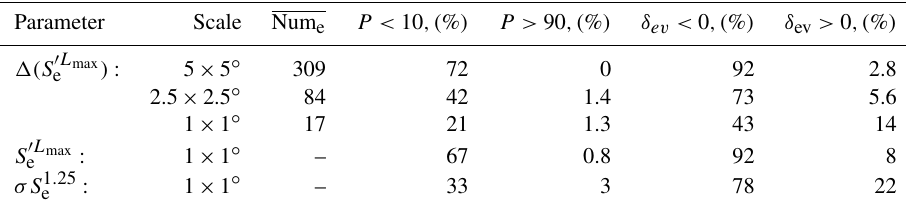
Table 1. General statistics of the average event number and percentile P e and δ e difference estimated at various scales for three soil moisture (cid:48) L max (cid:48) L max parameters: soil moisture gradient (cid:49)(S e ) , temporal soil moisture anomaly S e and (not presented in the methodology) soil moisture variance over the 1.25 ◦ box σS 1 . 25 e . Percentiles P e < 10% ( > 90%) indicate a significant negative (positive) δ e difference, and hence a negative (positive) SMPC